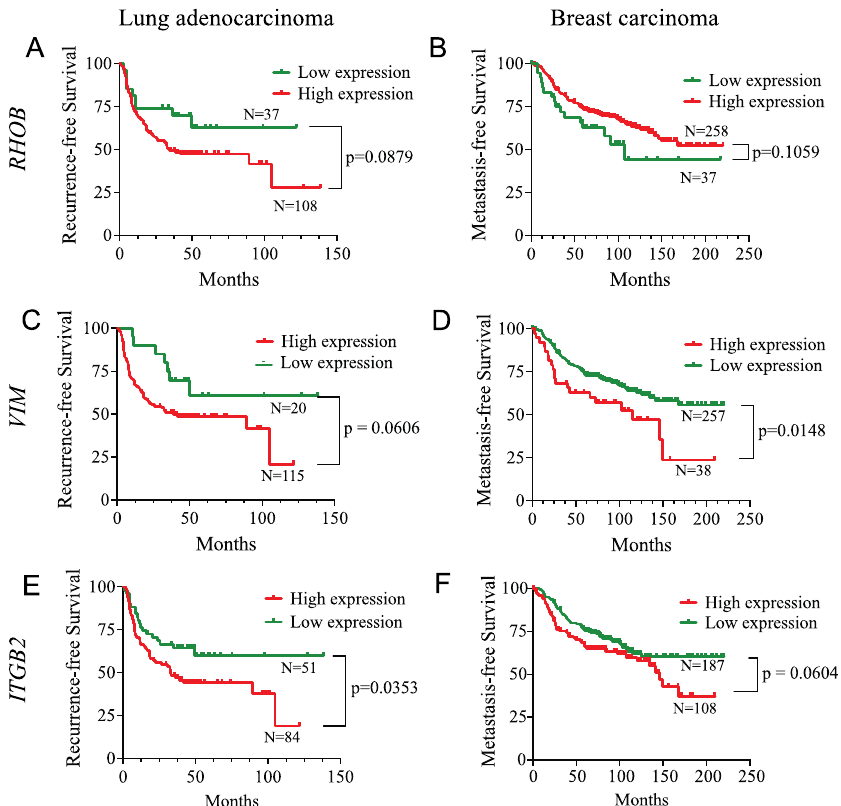
Figure 11. SMAD3 Invasion-Related Gene Signature Correlates with Lung and Breast Cancer Pro- gression. Lung adenocarcinoma and breast carcinoma cancer patient cohorts were segregated into high- and low- risk groups for metastasis/recurrence-free survival using SurvExpress online software. Kaplan–Meier curves for high- (red) and low- (green) RHOB ( A , B ), VIM ( C , D ) or ITGB2 ( E , F ) gene expression in lung adenocarcinoma ( A , C , E ) and breast carcinoma ( B , D , F ) human tumors are presented. Gehan–Breslow–Wilcoxon test was performed to assess p -value.